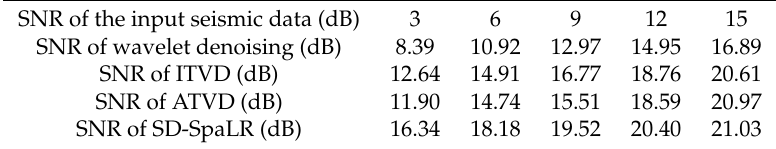
Table 1. Variation of the SNR of denoising results with the SNR of the input seismic data.